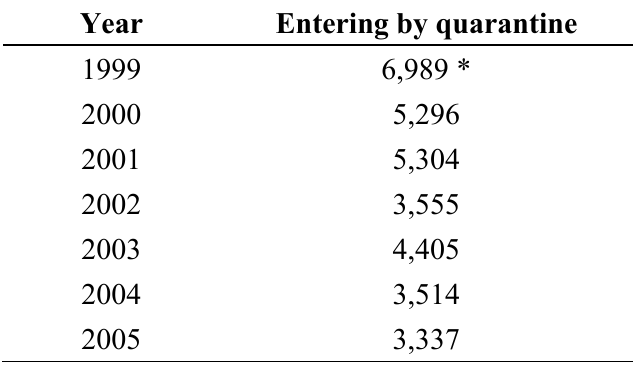
Table 1. Dogs and cats imported into the UK between 1999 through 2005. Data obtained from The Report of the Chief Veterinary Officer—Animal Health 2005 (Defra,